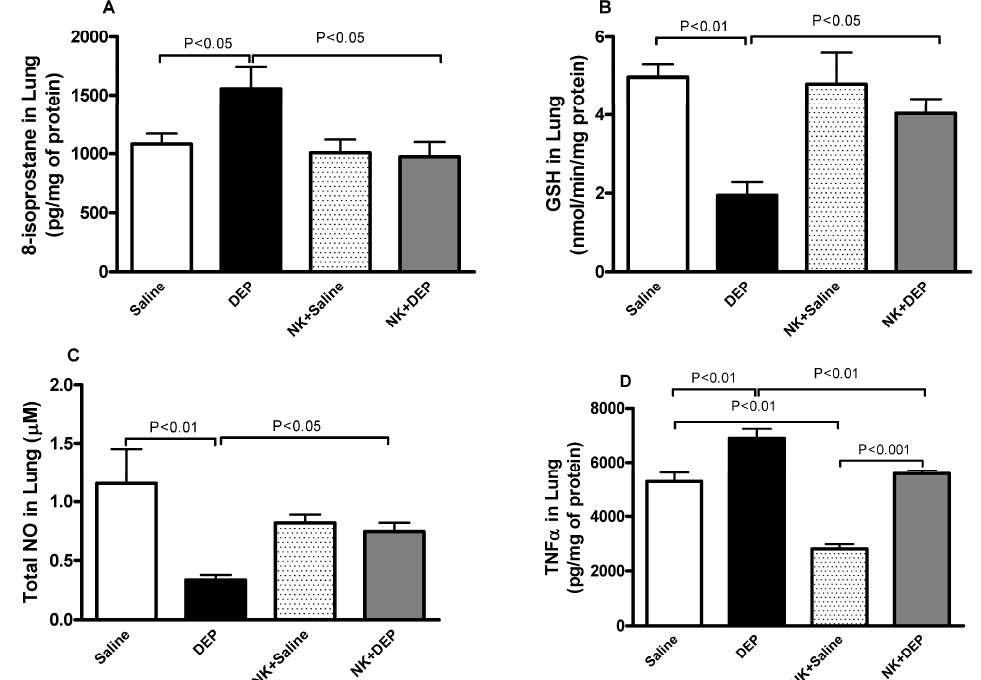
Figure 4. Lung homogenate levels of 8-isoprostane ( A ); reduced glutathione (GSH, B ); total nitric oxide (NO, C ) and tumor necrosis factor α (TNF α , D ); 24 h after intratracheal instillation of either saline or diesel exhaust particles (DEP, 30 µg/animal) with or without nootkatone (NK) pretreatment. Data are mean ± SEM ( n = 5–8 in each group).